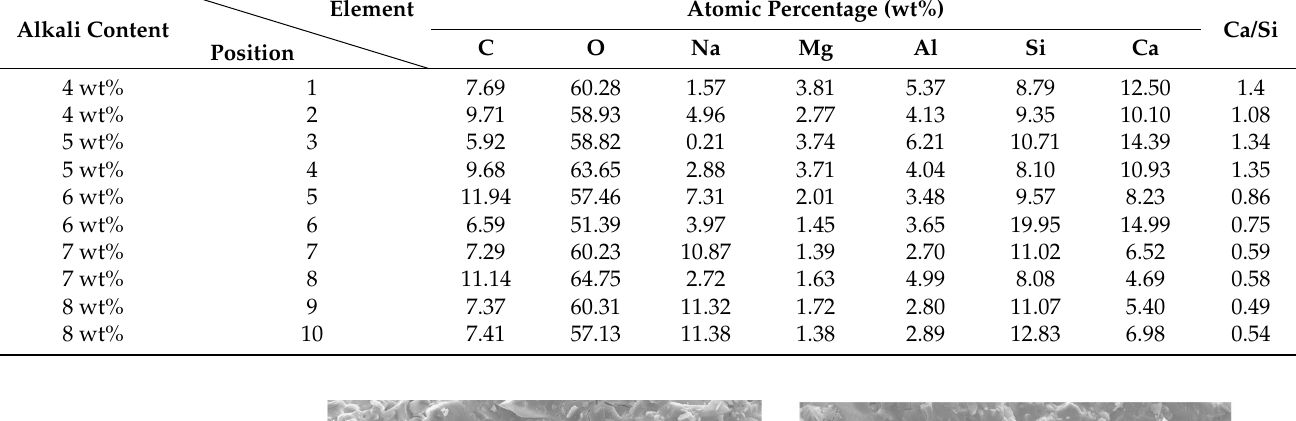
Table 2. Chemical element compositions of products tested by EDS.